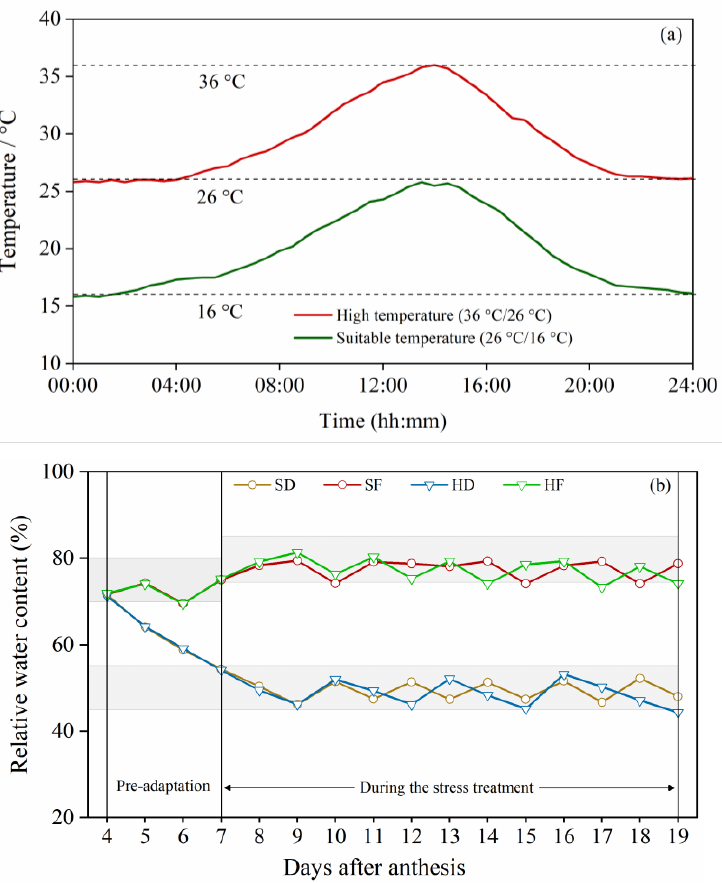
Figure 2. Changes in daily temperature ( a ) and soil water content ( b ) during the stress treatment.